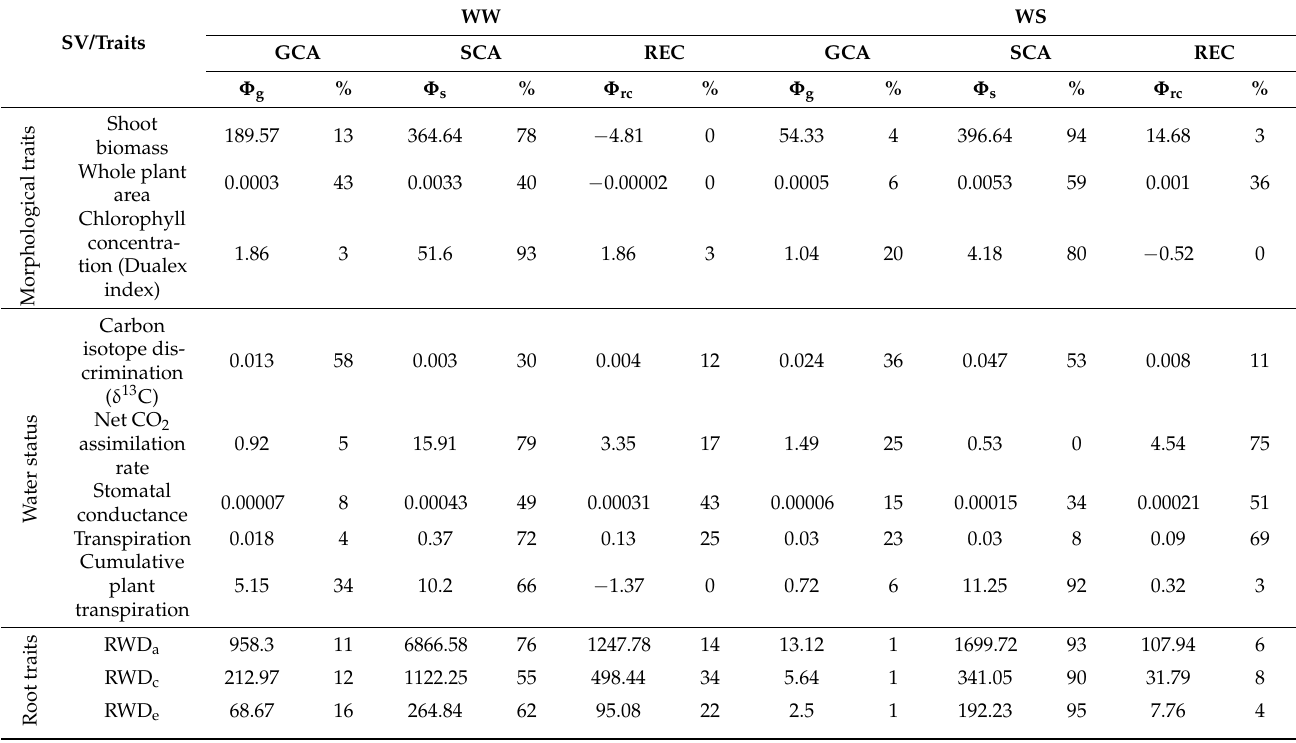
Table 2. Analysis of variance and quadratic components for three groups of traits evaluated in popcorn, with exposure to different water conditions (WS: water stress, and WW: well-watered), according to the Method I proposed by Griffing (1956) for a diallel involving four inbred lines, their F 1 (cid:48) s, and reciprocal